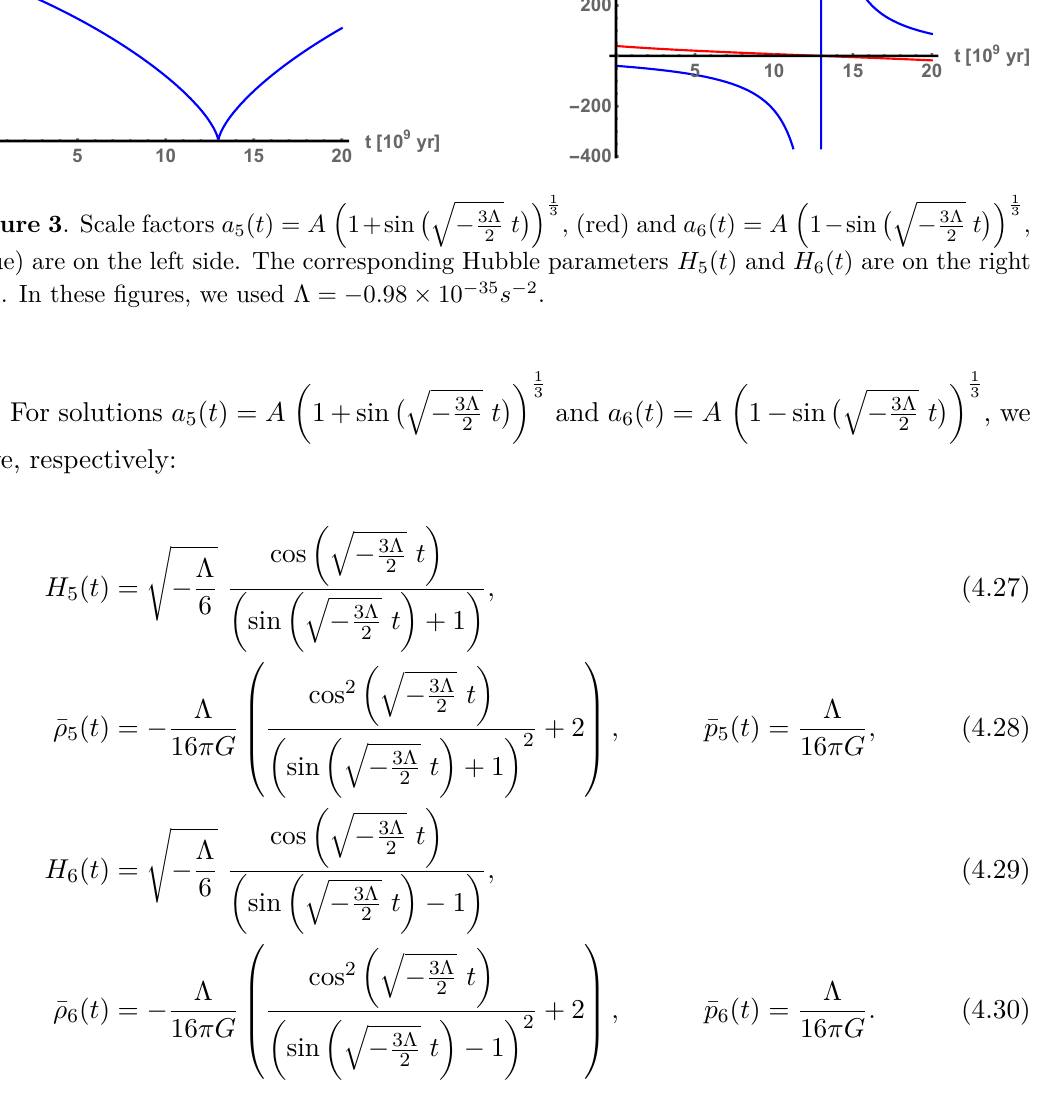
(cid:0)q (cid:16) (cid:1)(cid:17) 1 3 , (red) and a 1+sin − 3Λ t 2